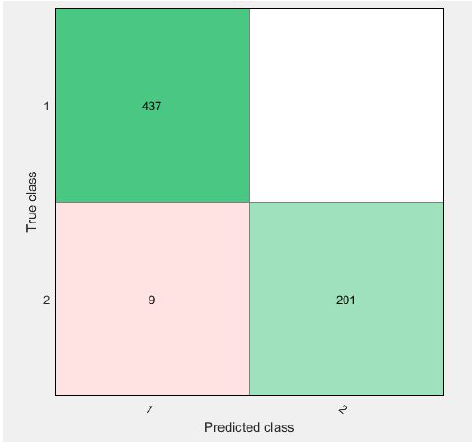
Figure 10. Confusion matrix of parallel fusion using 10-fold classification with